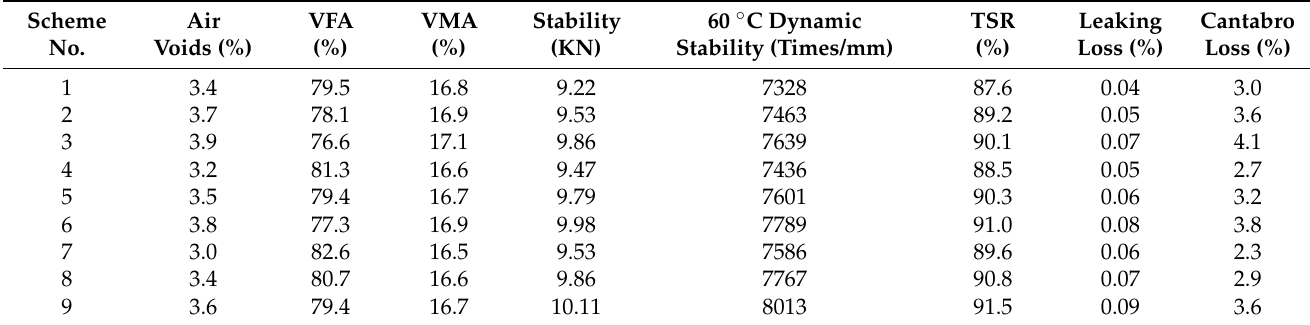
Table 4. Mechanical performance of SMA-13 specimens.